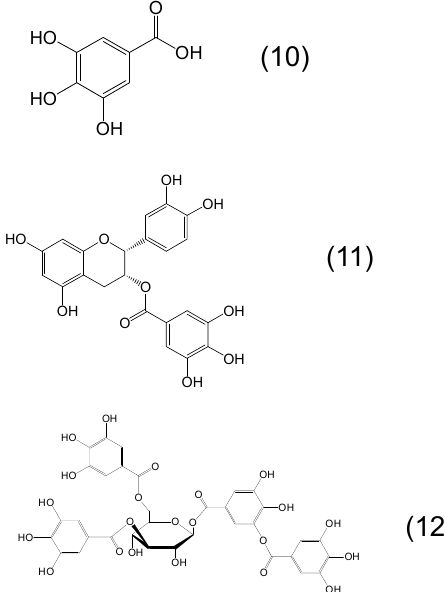
Figure 4. Examples of phytochelators with the chemical structure containing trihydroxybenzene as the metal binding site moiety. Gallic acid or 3,4,5-trihydroxybenzoic acid ( 10 ), epigallocatechin or (2 R ,3 R )-2-(3,4,5-trihydroxyphenyl)-3,4-dihydro-2 H -chromene-3,5,7-triol ( 11 ) and tannic acid or 2,3-dihydroxy-5-({[(2 R ,3 R ,4 S ,5 R ,6 R )-3,4,5,6-tetrakis({3,4-dihydroxy-5-[(3,4,5-trihydroxyphenyl)carbo